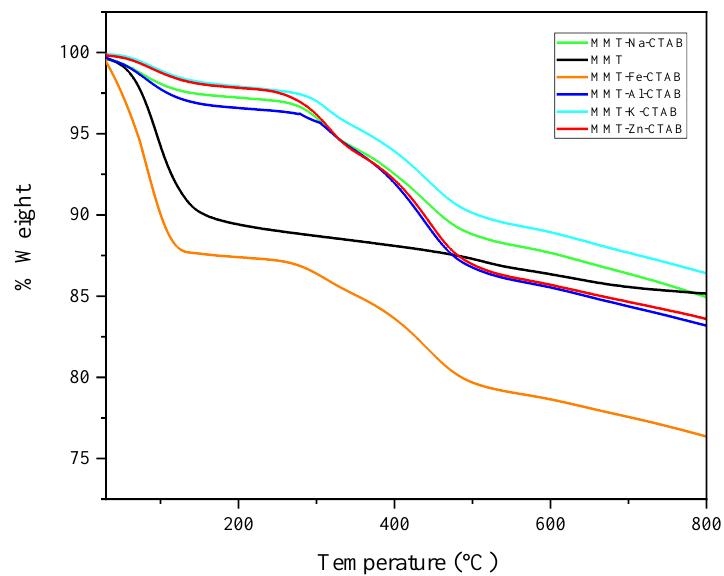
Figure 2. Thermogravimetric analysis of raw Mt, Mt-Fe-CTAB, Mt-Al-CTAB, Mt-Mg-CTAB, Mt-Na-CTAB, and Mt-Zn-CTAB.